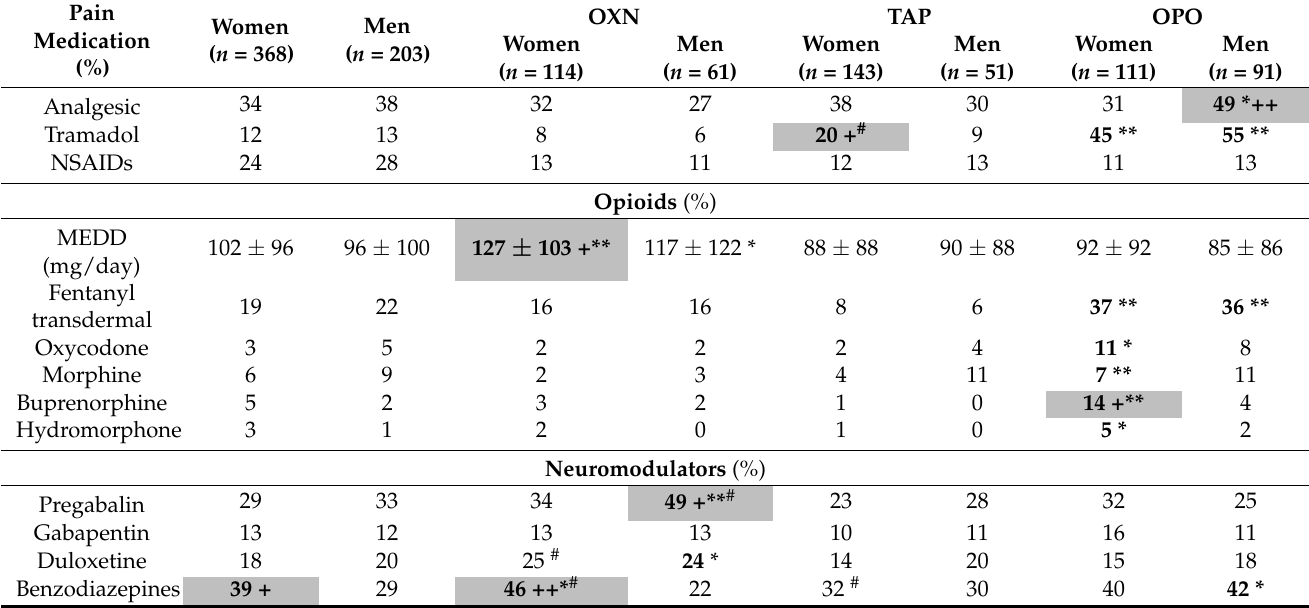
Table 2. Analgesic drug prescription depending on group and sex.